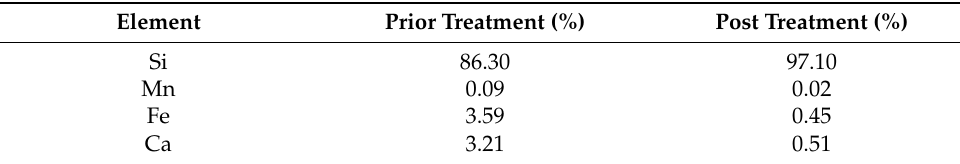
Table 2. Component analysis of unleached and leached